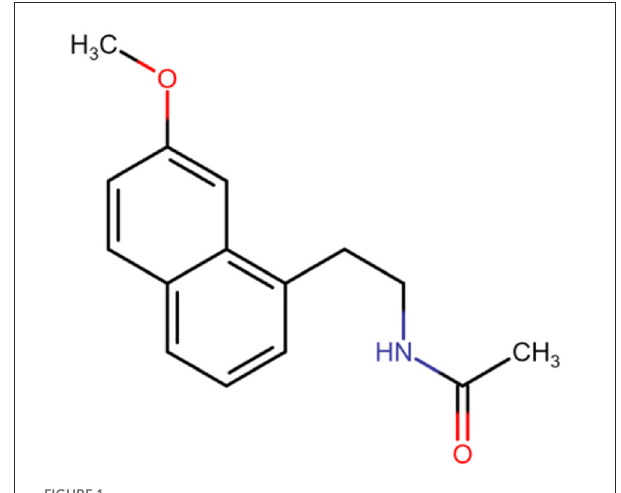
FIGURE1 Chemical structure of